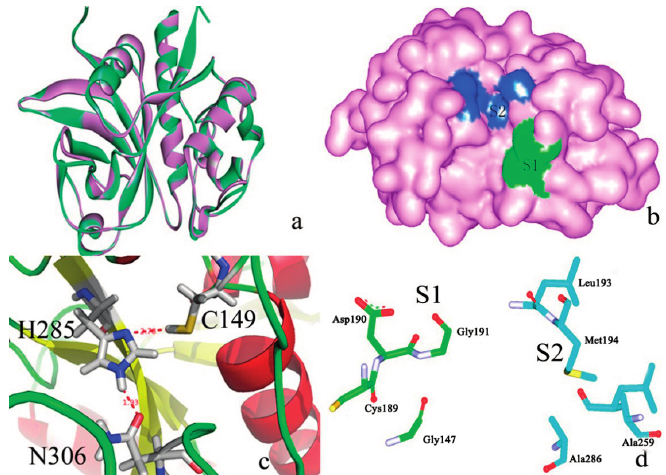
Figure 4. ( a ) Structure superimpose between zmCP1 (green) and the template (purple); ( b ) S1 and S2 pocket in the protein contact potential of zmCP1; ( c ) Catalytic triad of zmCP1: Cys149, His285, and Asn306; ( d ) The S1 (Gly147, Gly191, Cys189, and Asp190) and S2 (Leu193, Met194, Leu283, and Ala286) residues in